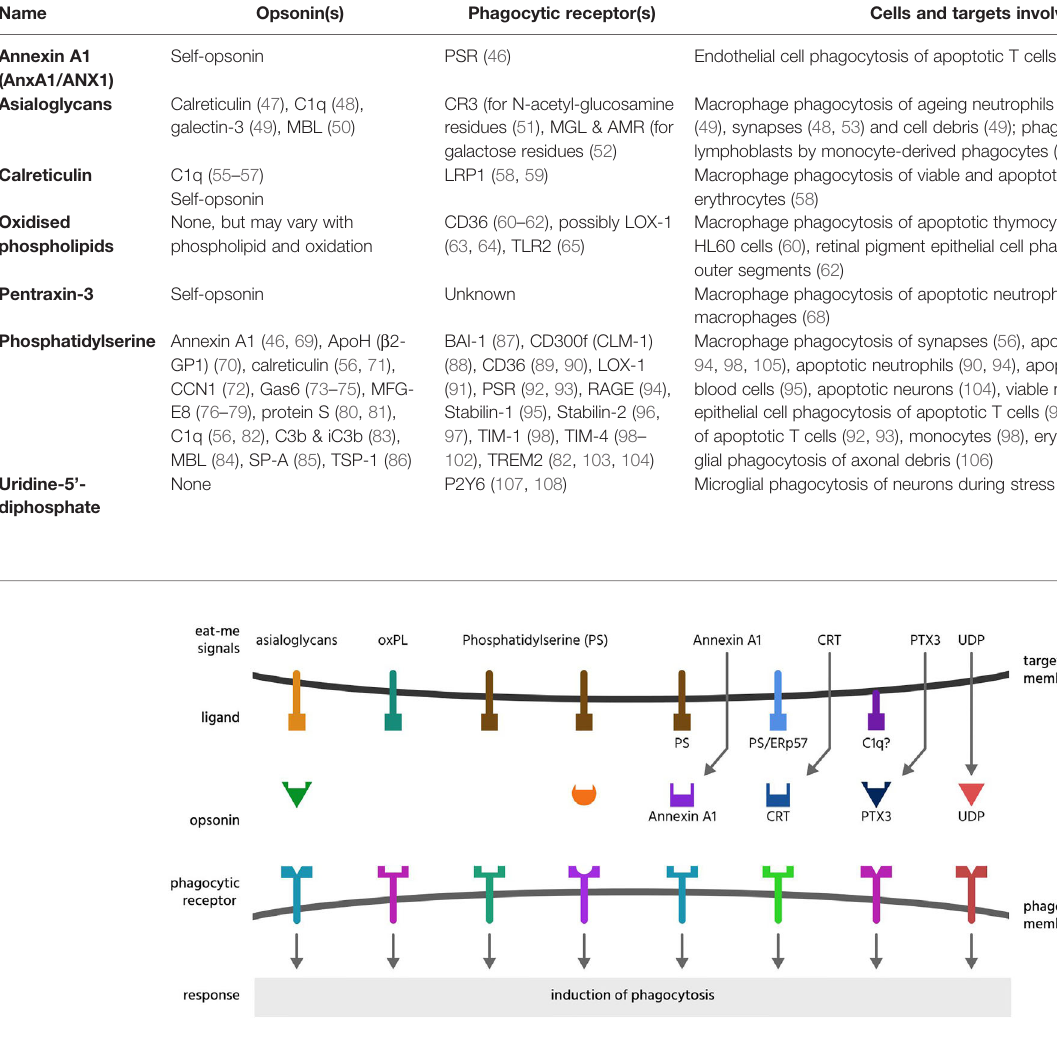
FIGURE 2 | Eat-me signals. Eat-me signals are molecules exposed on or released from a target cell to directly induce phagocytosis of that cell by a phagocyte. The fi gure illustrates eat-me signals on or from mammalian target cells. Asialoglycans are desialylated glycoproteins or glycolipids, that can bind multiple opsonins, and induce phagocytosis via multiple receptors. Oxidised phospholipids (oxPL) can induce phagocytosis via receptors CD36 and LOX-1. Phosphatidylserine (PS) can induce phagocytosis either directly via multiple phagocytic receptors or indirectly via binding multiple opsonins. Annexin A1, CRT (calreticulin) and PTX3 (pentraxin 3) are soluble proteins released onto the surface of target cells, where they bind ligands: PS (phosphatidylserine), C1q (complement component C1q) or ERp57 (endoplasmic reticulum resident protein p57). UDP (uridine-5 ’ -diphosphate) can induce phagocytosis via activating the P2Y6